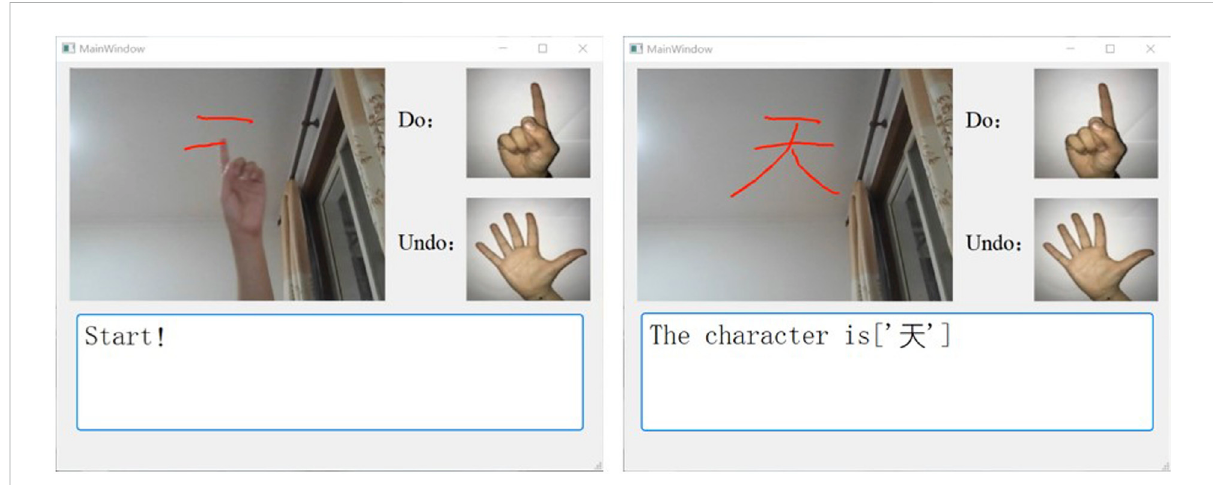
FIGURE 3 Illustrationofoneexampleoftherehabilitationgameexperience. (A) showstheprocessofwritingintheair. (B) showstheresultofthecharacter